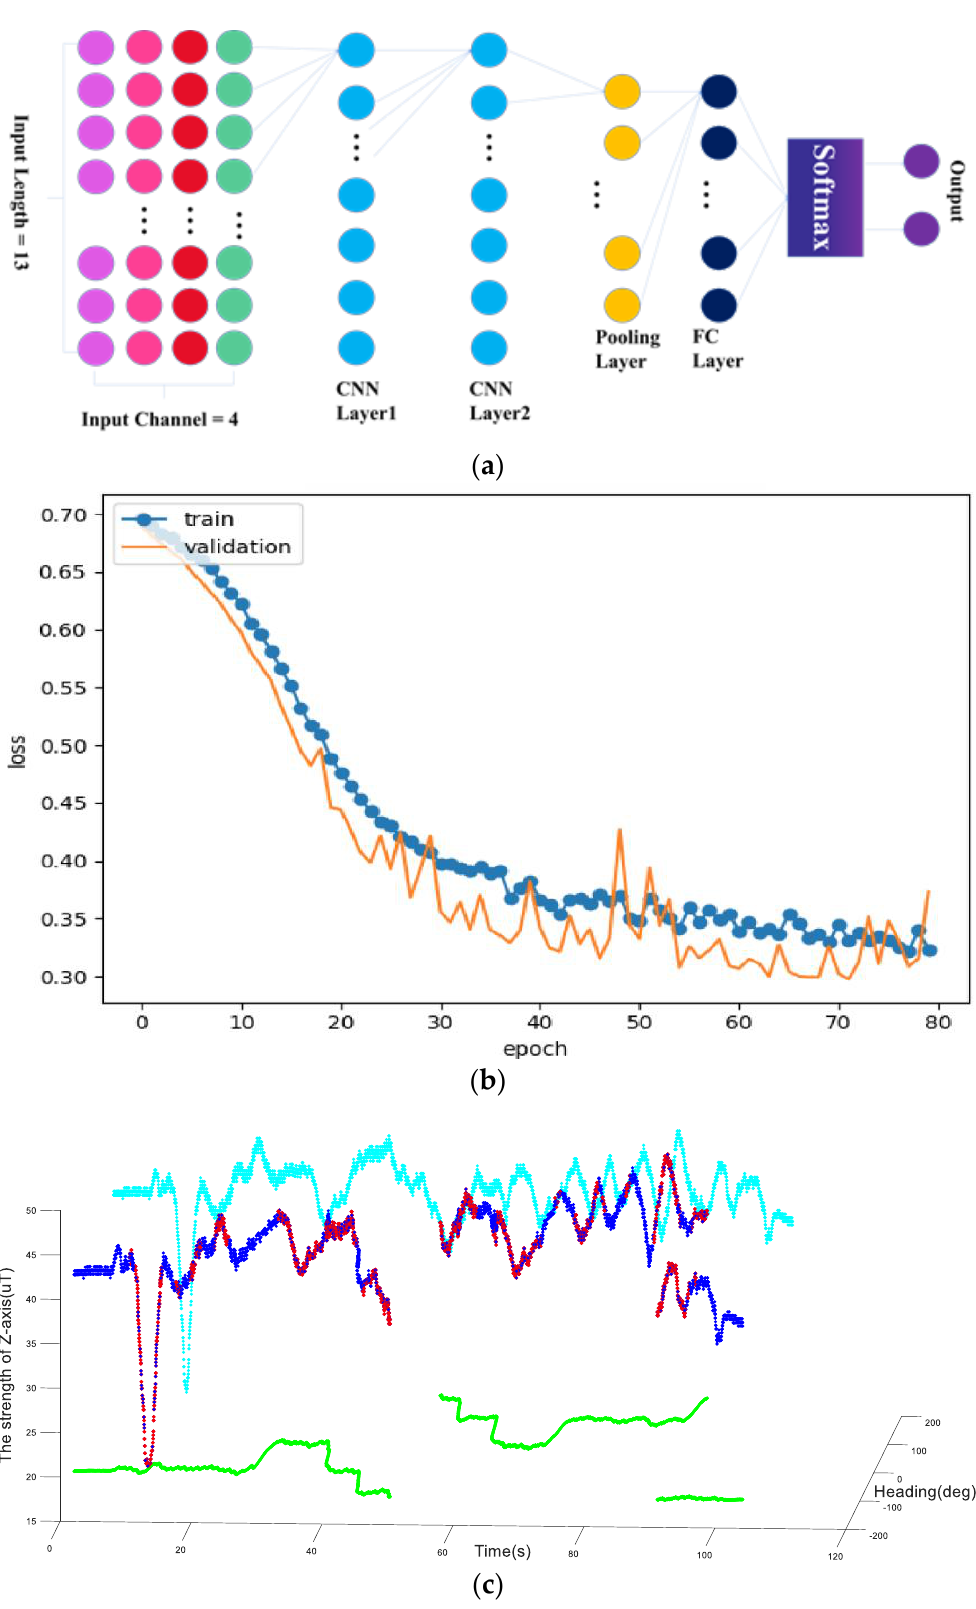
Figure 4. ( a ) The topological structure of the 1D CNN network. ( b ) The decrease in the loss function with training. ( c ) Magnetic data classification results based on 1D CNN.